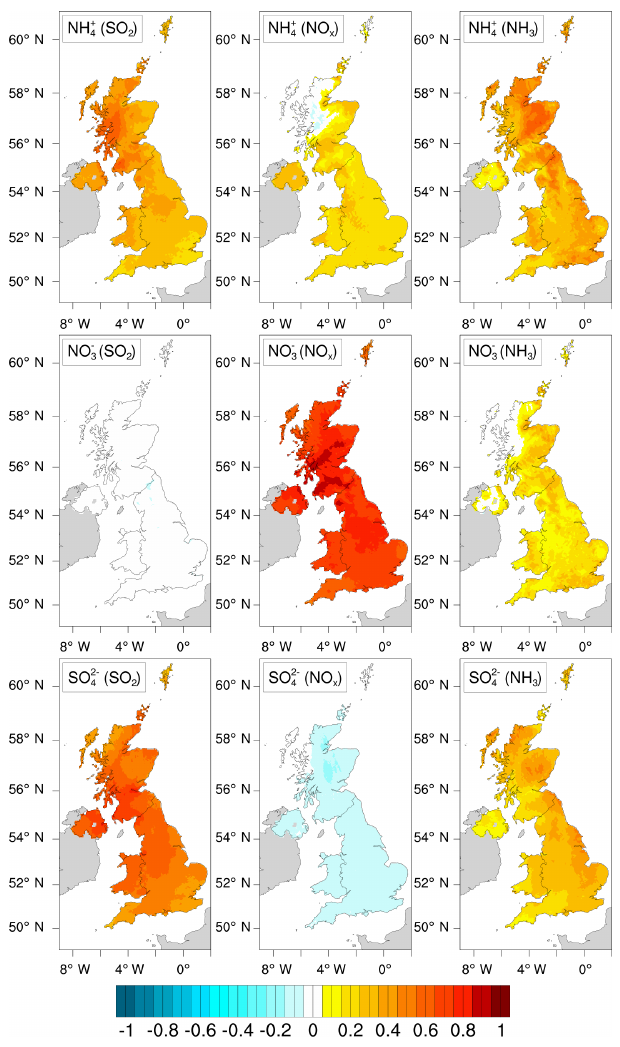
Figure 2. Spatial distributions (at the 5km × 5km model grid reso- lution) of RCs for particulate NH + of variation in input emissions of SO 2 , NO x , and NH 3 . The model input emissions for which the RC quantifies the output variable sen- sitivity is given in brackets in each panel.